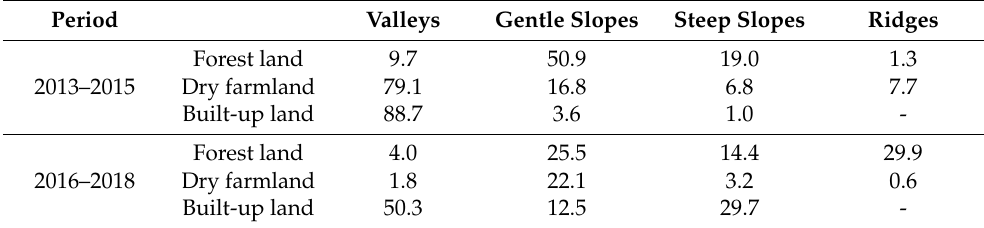
Table 7. Interpretations of TP and TN by land use composition on different TPIs.